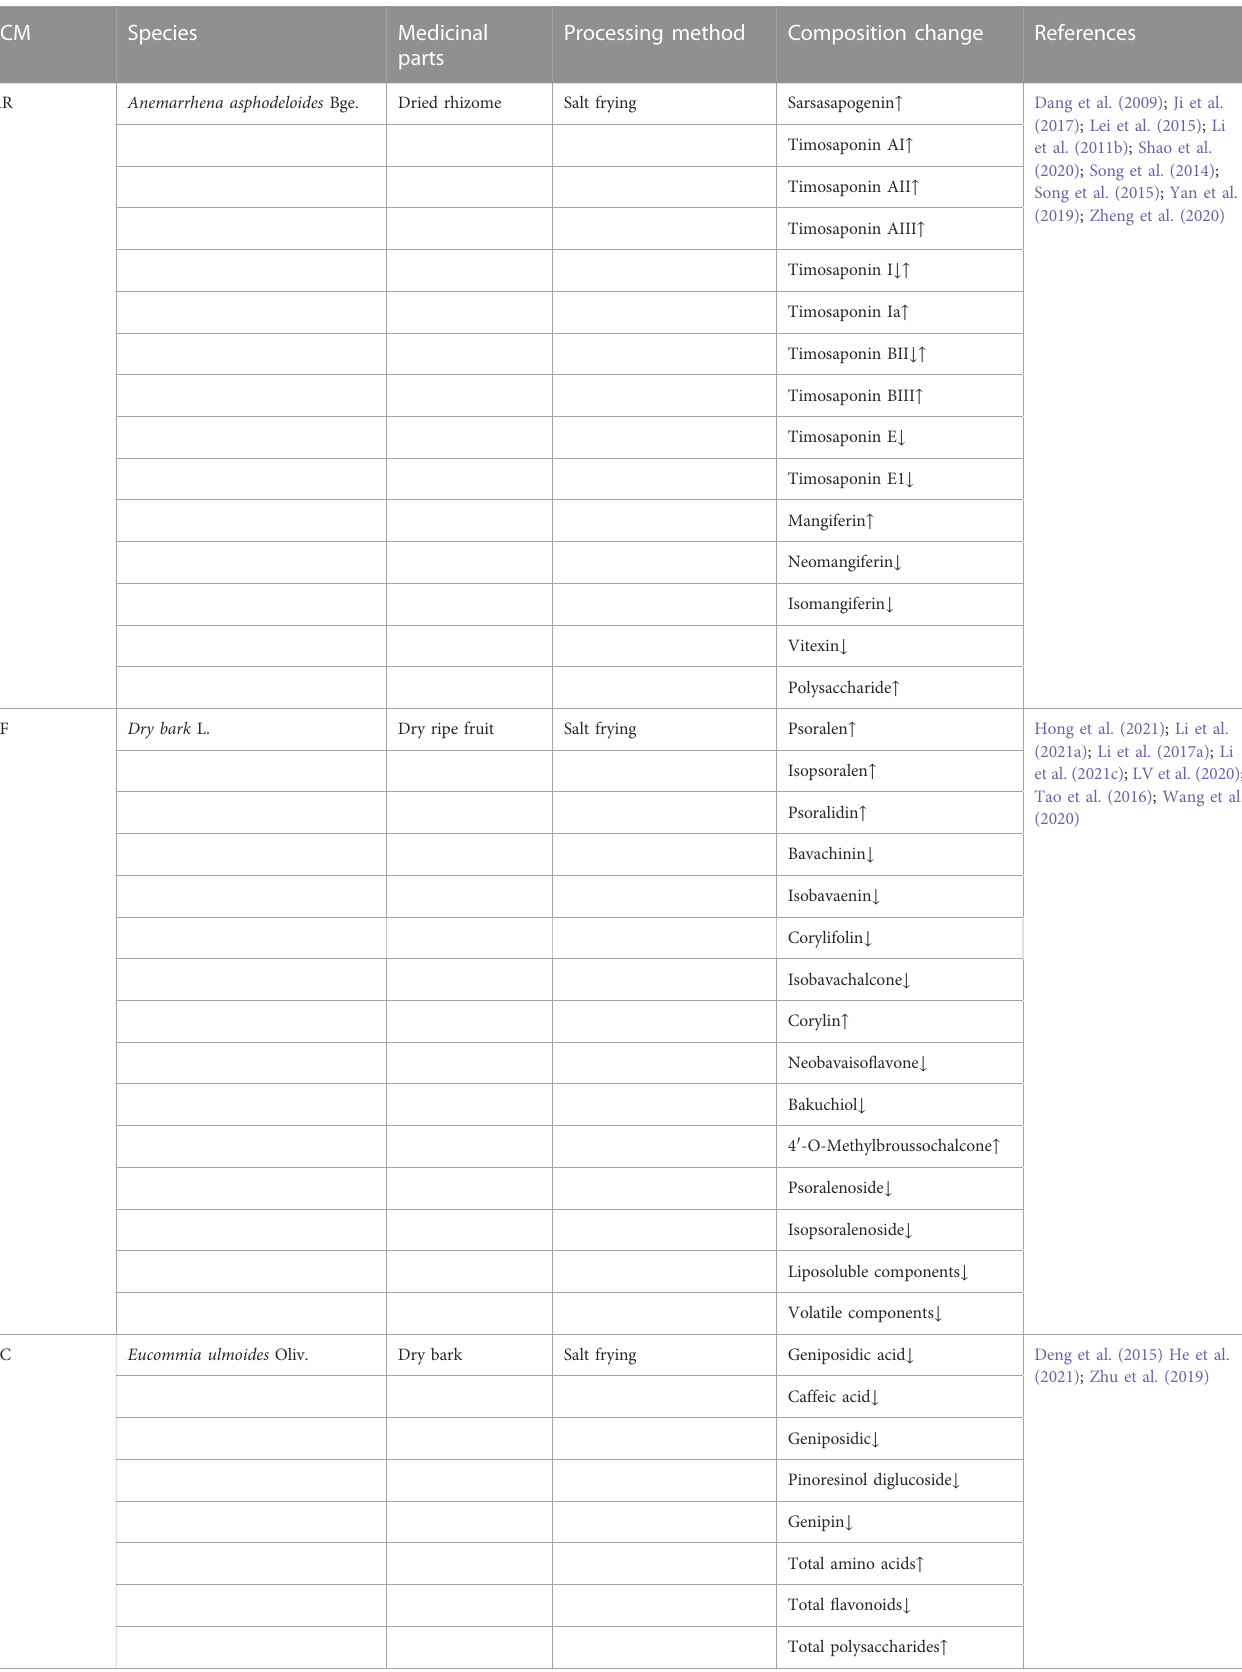
AR Anemarrhena asphodeloides